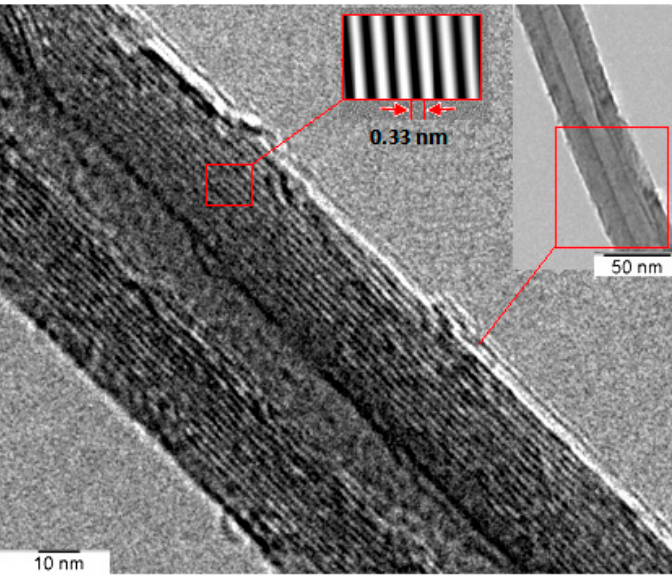
Figure 4. TEM micrograph of pristine MWCNTs.